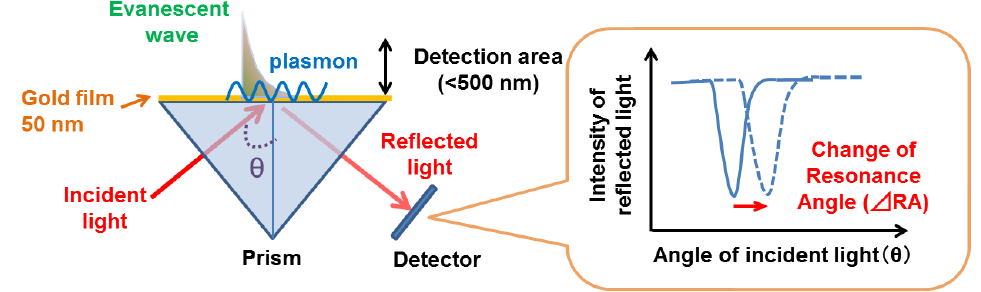
Figure 1. Principle of SPR sensor. Surface plasmon resonance (SPR) sensors detect a refractive index (RI) changes within a detection area (<500 nm) as a change of resonance angle (RA).